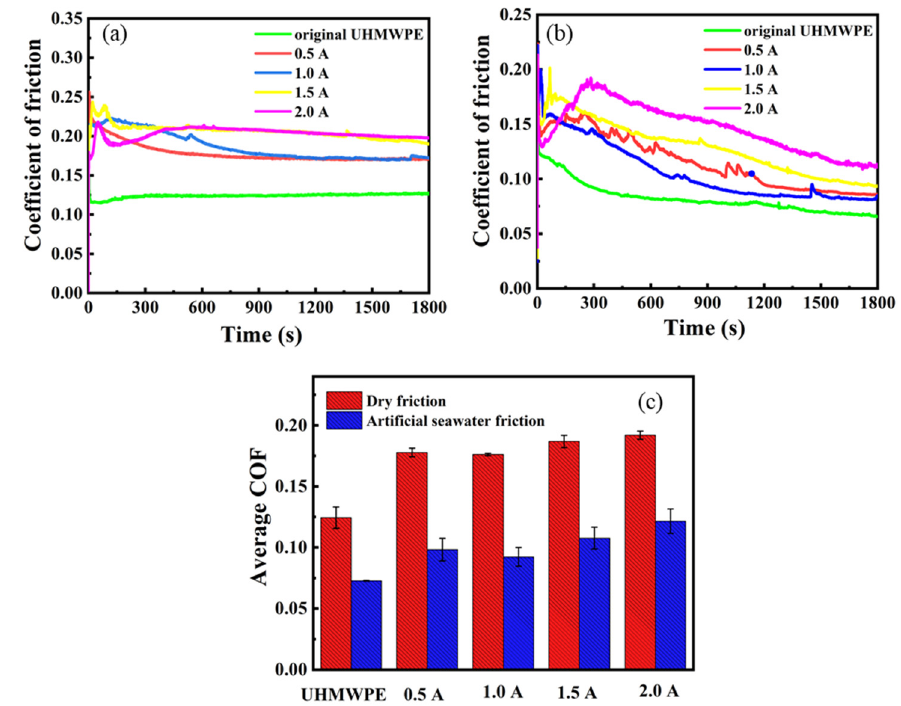
Figure 11. The friction coefficient of UHMWPE substrates treated with different carbon plasma currents under dry friction and artificial seawater friction: ( a ) the friction coefficient curve under dry friction, ( b ) the friction coefficient curve under artificial seawater friction, ( c ) the average friction coefficient under two environments.